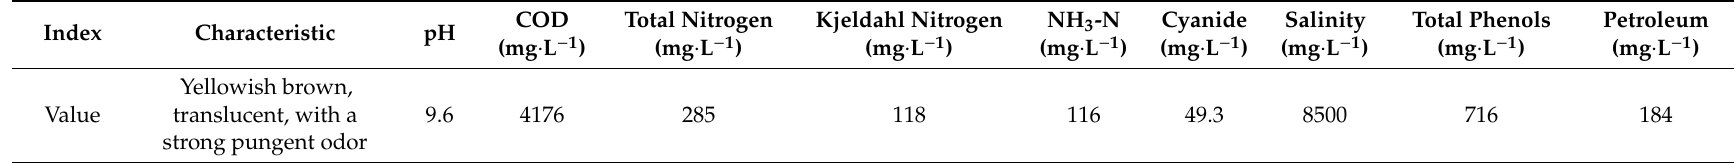
Table 1. Raw water quality of coking